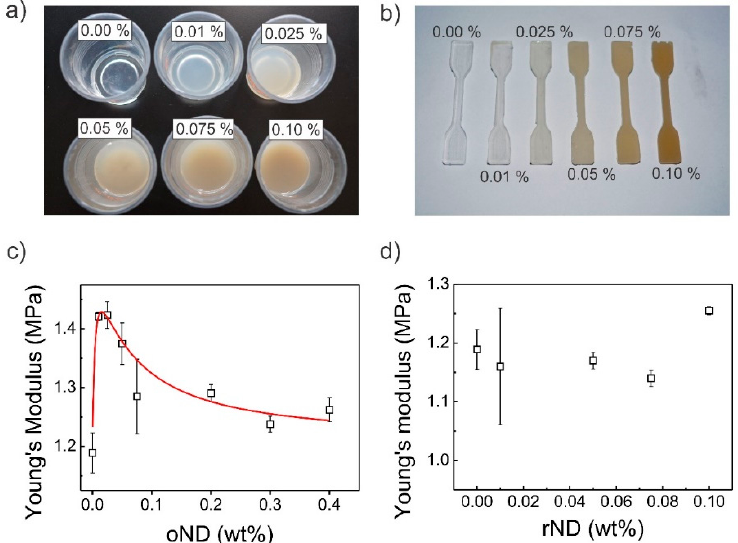
Figure 2. ( a ) Optical images of bulk polydimethylsiloxane (PDMS) / oND composite before curing and ( b ) after curing in a standardized mold. The percentage numbers denote the weight percentage of oxidized nanodiamond in the nanocomposite. Young’s moduli of bulk PDMS / ND composites with increasing ND content. ( c ) Oxidized hydrophilic ND particles and ( d ) reduced hydrophobic nanoparticles were blended into the PDMS prepolymer prior to